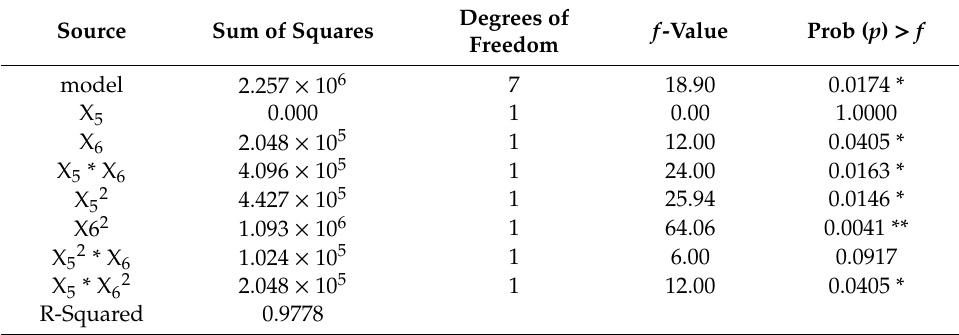
Table 8. The analysis of variance for the regression